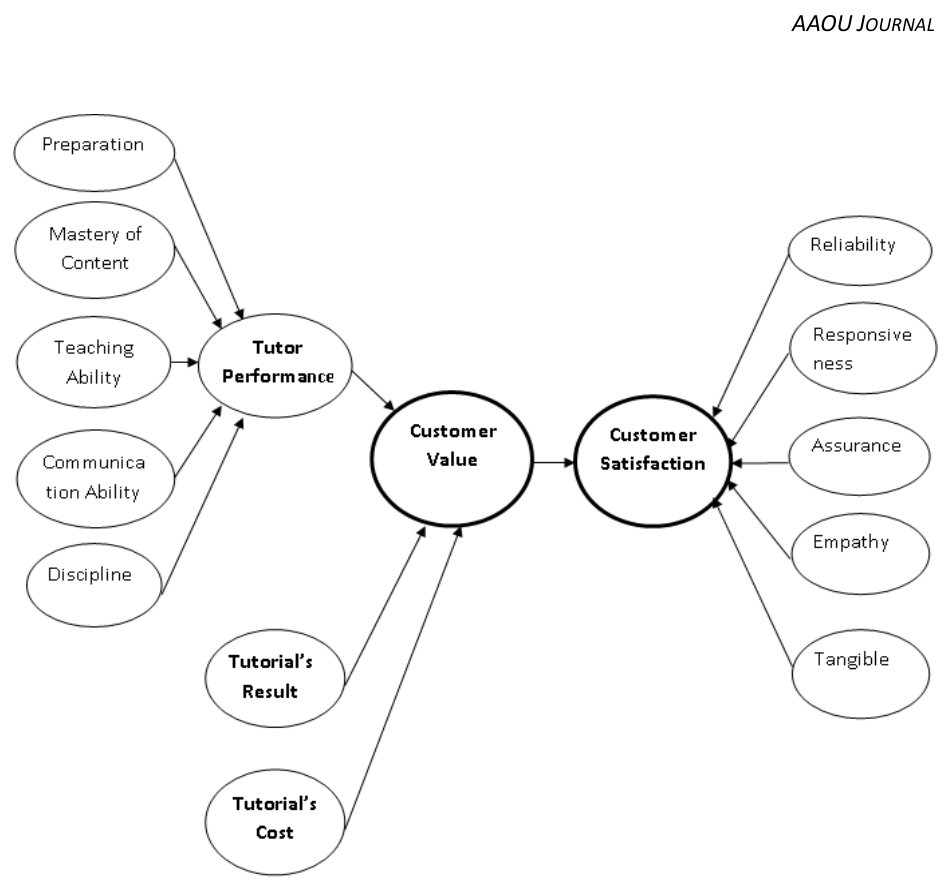
Figure 1 The relationship between variables